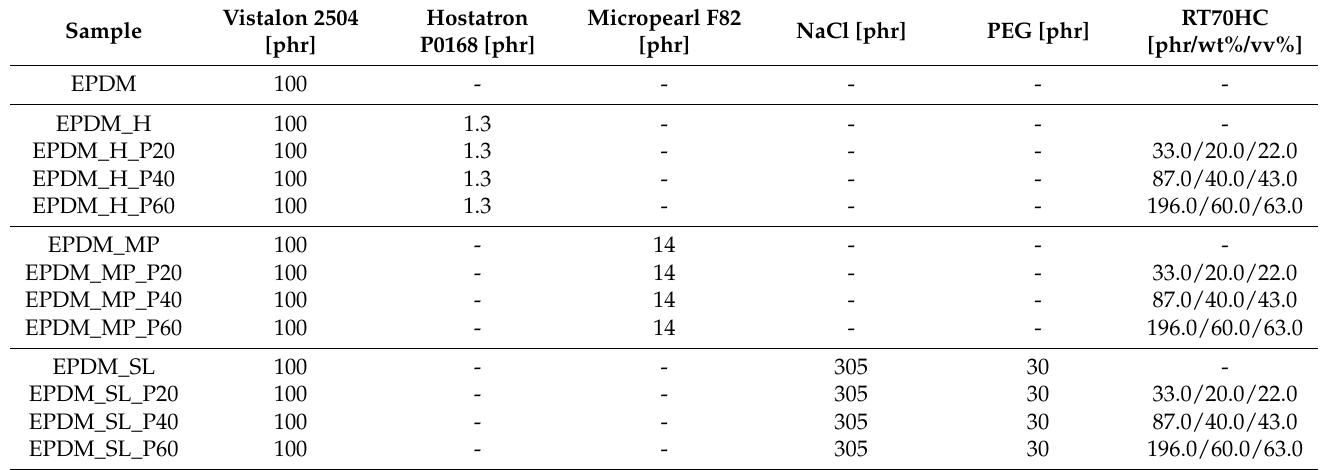
Table 3. List of the prepared samples and their nominal